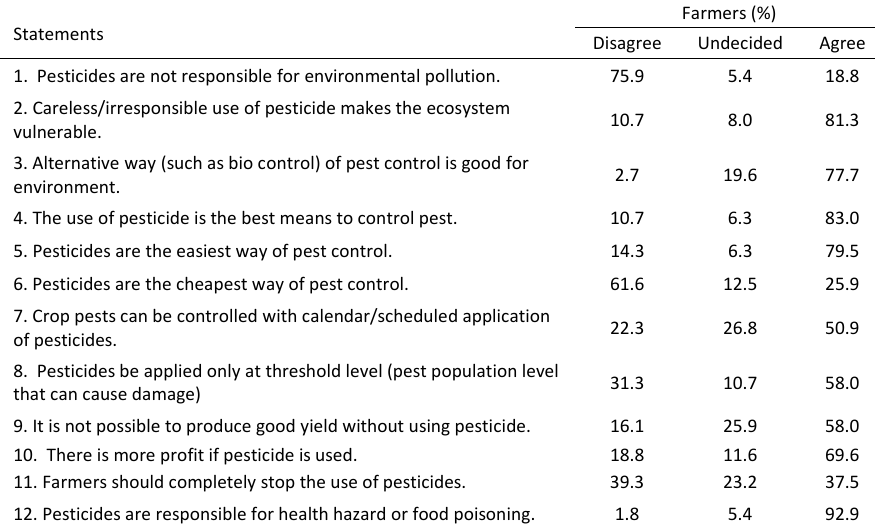
Table 6: Perceptions of farmers towards pesticide use